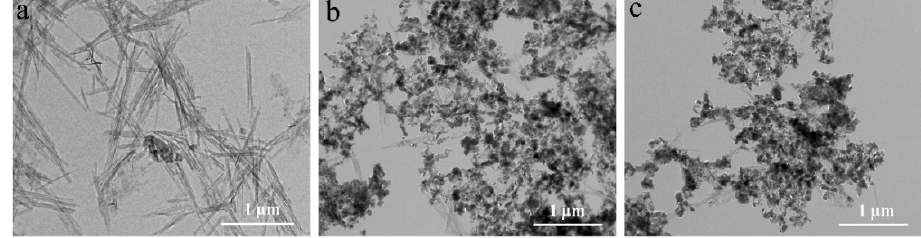
Figure 6. TEM images of ( a ) PAL, ( b ) ZnO/PAL, and ( c ) CAR/ZnO/PAL.